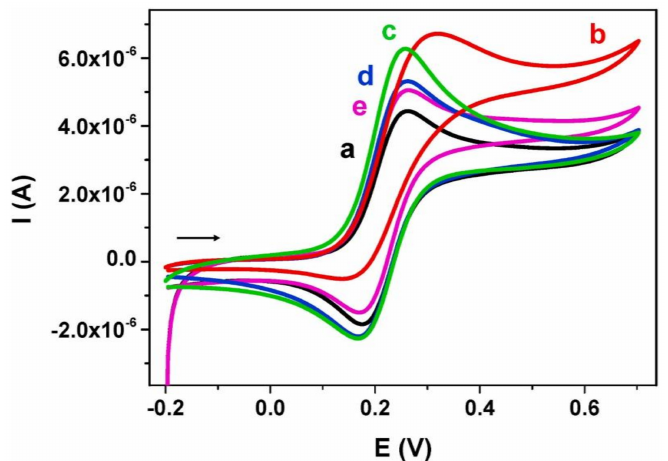
Figure 29. Cyclic voltammograms of Lactate in 0.1 M phosphate buffer with 1 mM HMF. (Reproduced from [559] with permission. Copyright 2022, Elsevier, Amsterdam, The